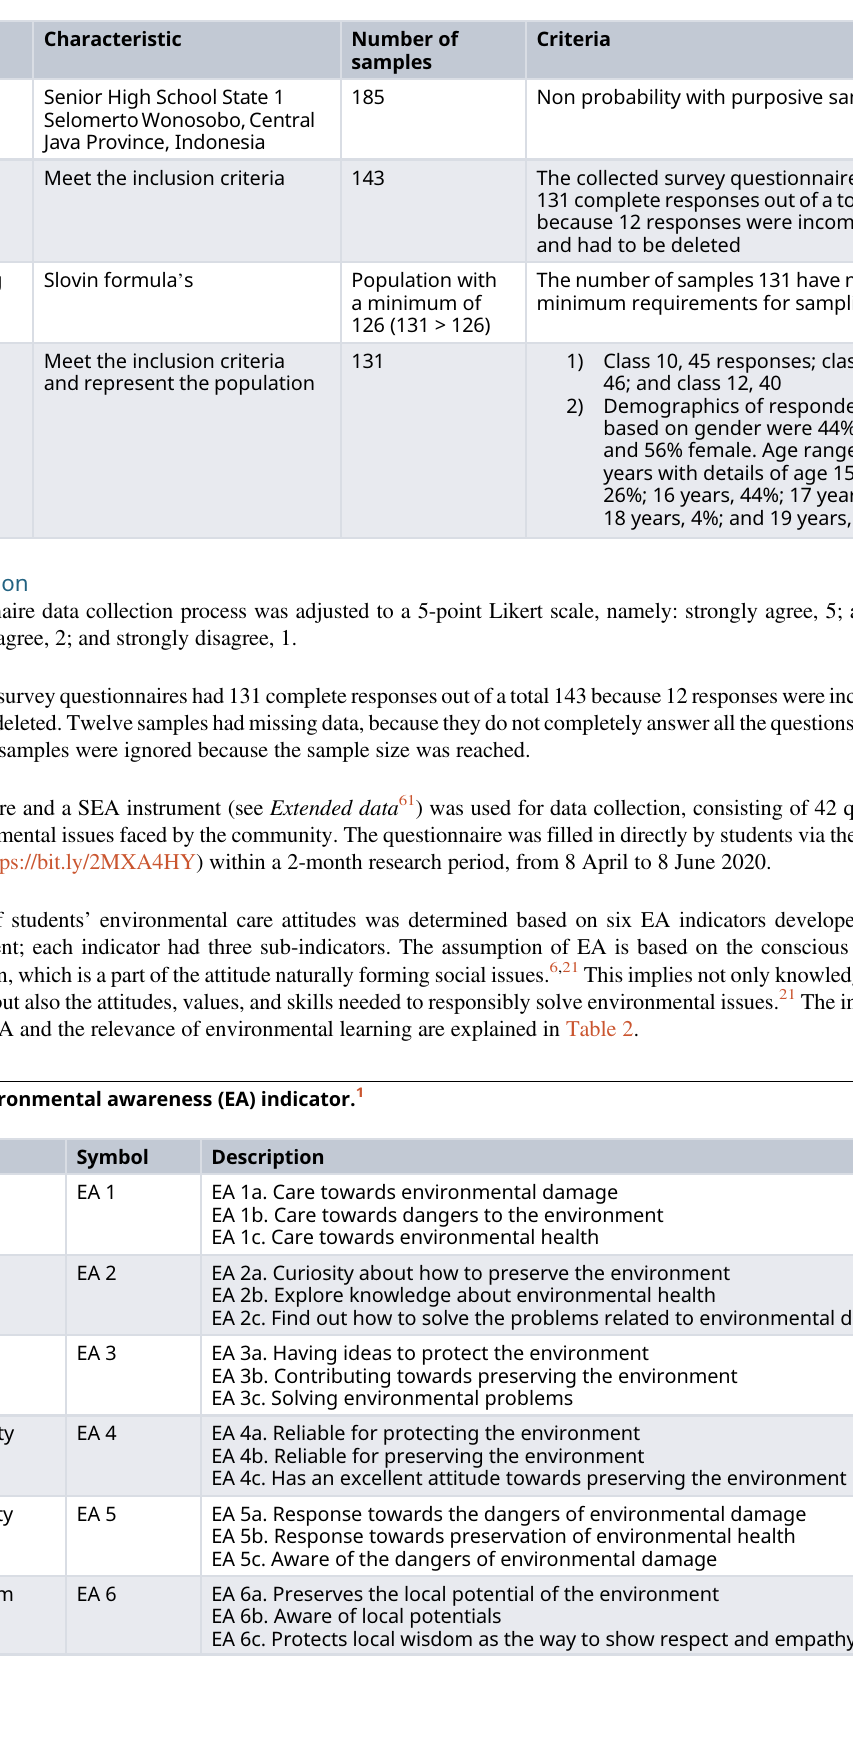
Table 1. The research sampling distribution.